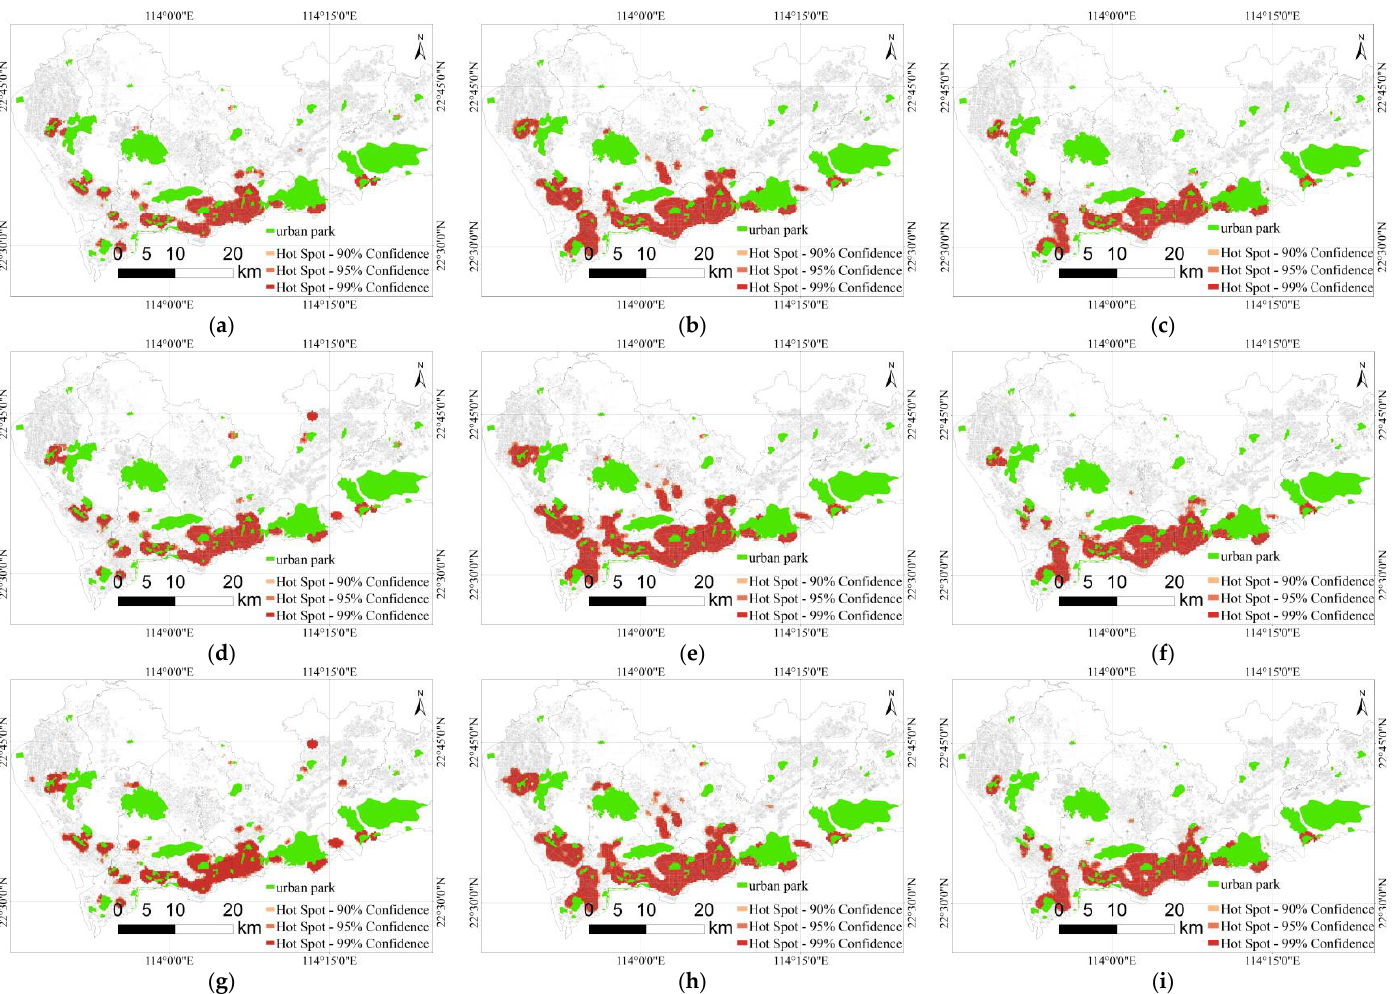
Figure 3. Distribution of the travel hotspots of the three groups on weekdays, weekends, and the National Day holiday. ( a – c ) Travel hotspots of Group 1, Group 2, and Group 3 on weekdays; ( d – f ) Travel hotspots of Group 1, Group 2, and Group 3 on weekends; ( g – i ) Travel hotspots of Group 1, Group 2, and Group 3 on the National Day